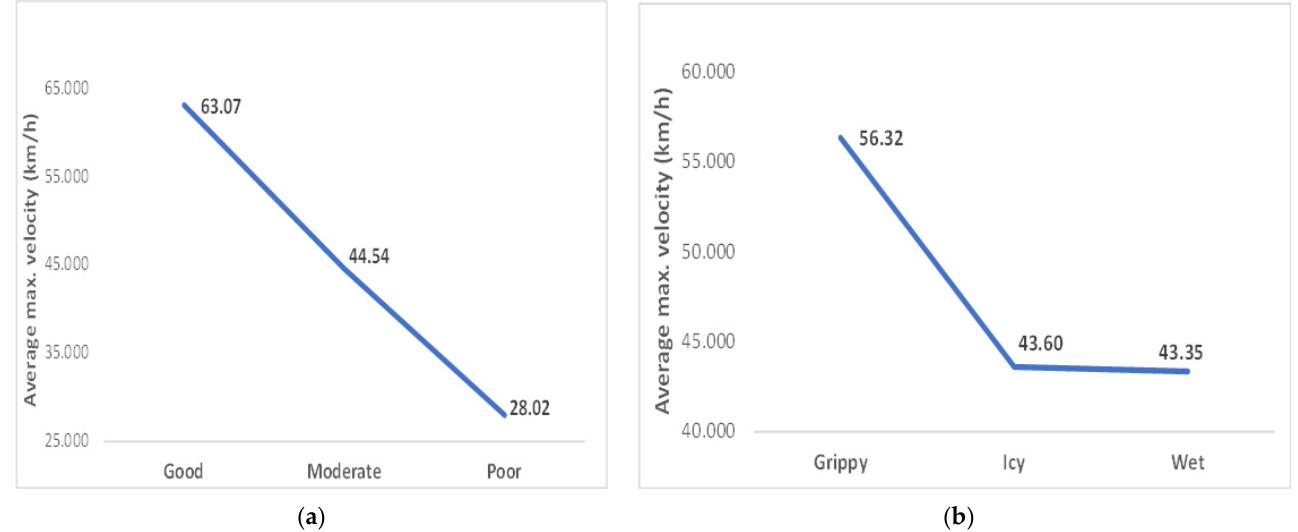
Figure 1. Maximum speed for visibility ( a ) and snow quality ( b ) categories.